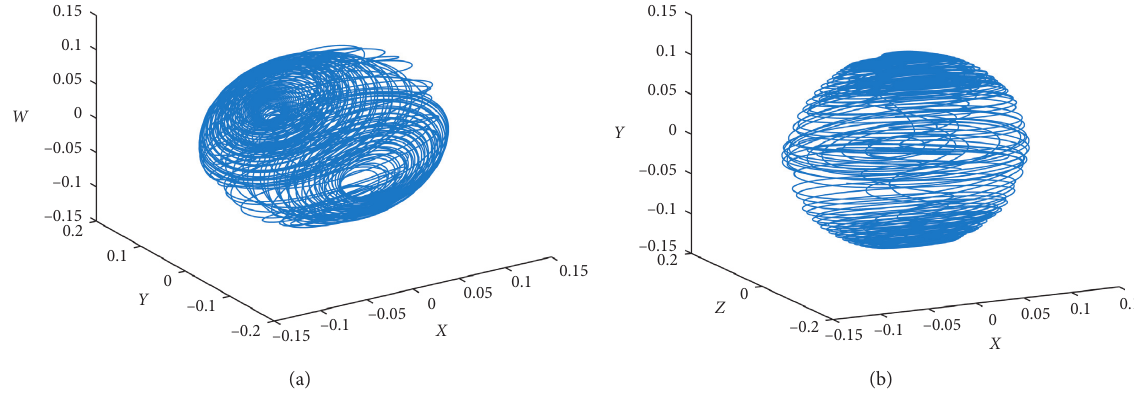
,y , z , w ) � ( 0 . 0918 , 0 . 08 , 0 . 00469 , 0 . 00290 ) , and 0 0 0 0